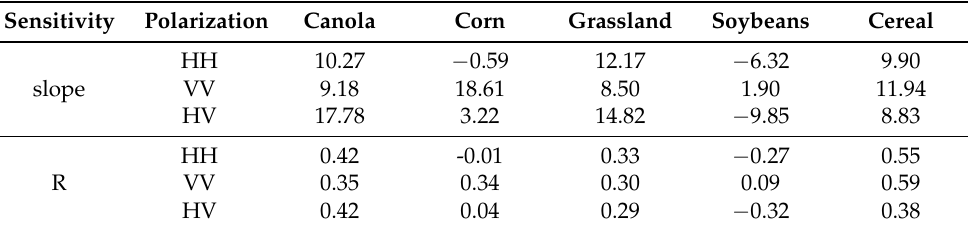
Figure 2. Sensitivity analysis between SAR backscattering coefficients and in situ SSM under different crops. ( a ) HH polarization and in situ SSM; ( b ) VV polarization and in situ SSM; ( c ) HV polarization and in situ SSM. Table 1. Slope and correlation coefficients (R) between in situ SSM and backscattering coefficients for different crop coverage